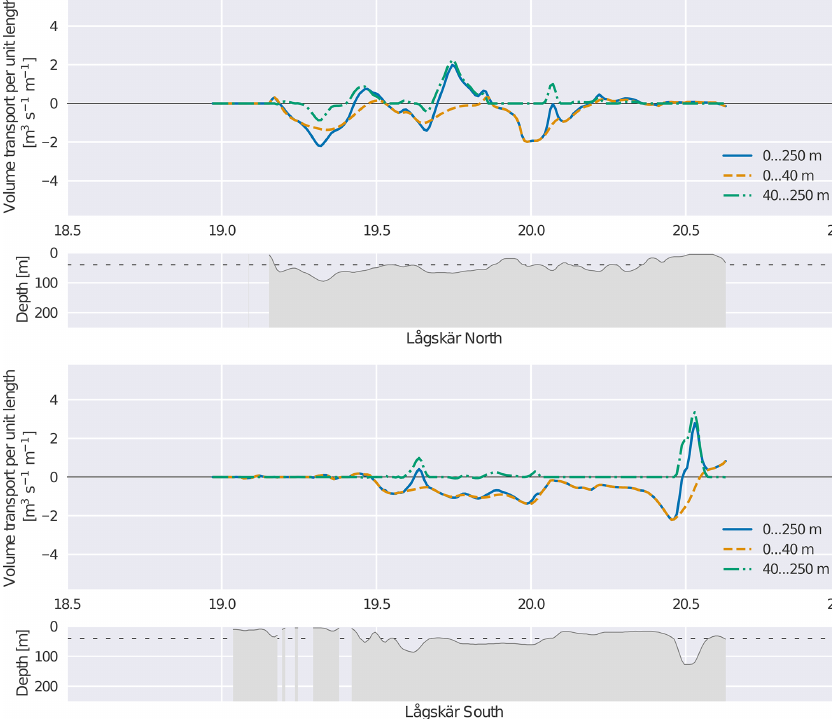
Ocean Sci., 18, 89–108, 2022